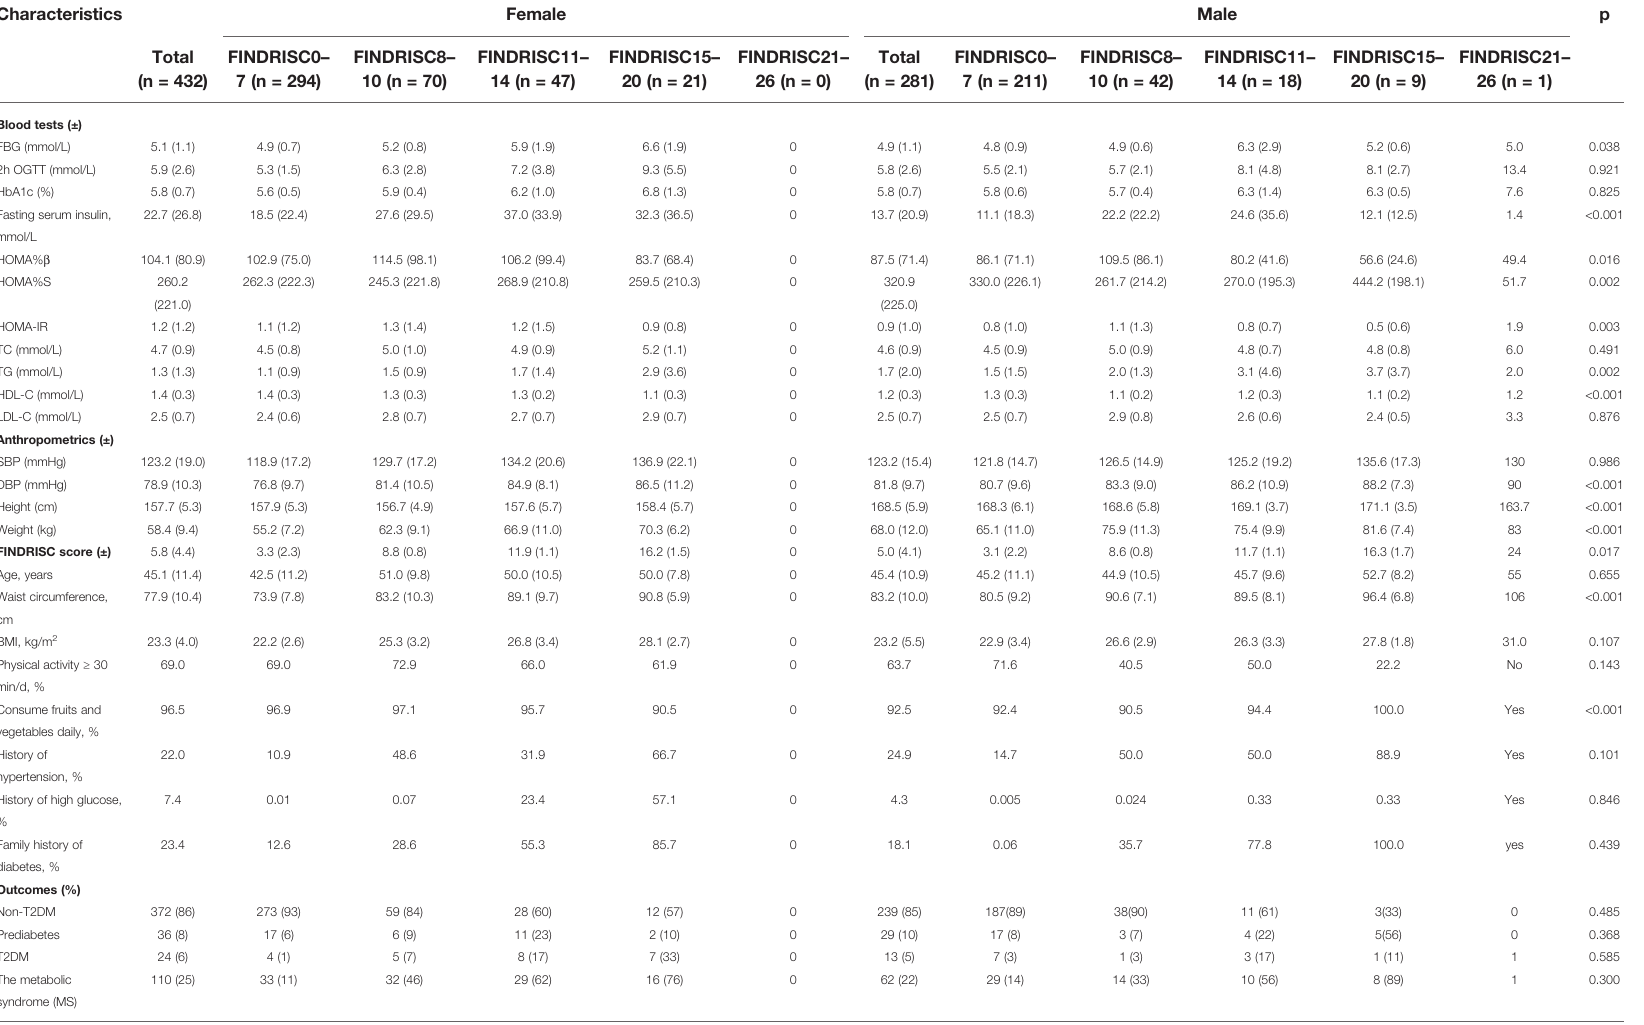
TABLE 2 | Prevalence of components of the modi fi ed version of the Finnish Diabetes Risk Score (FINDRISC) by sex.